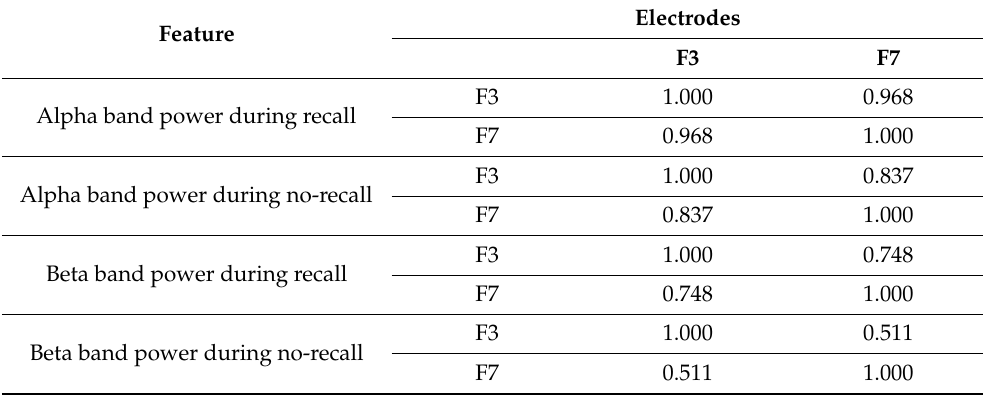
Table 5. Pearson correlation coefficient results for F3–F7 paired electrodes.